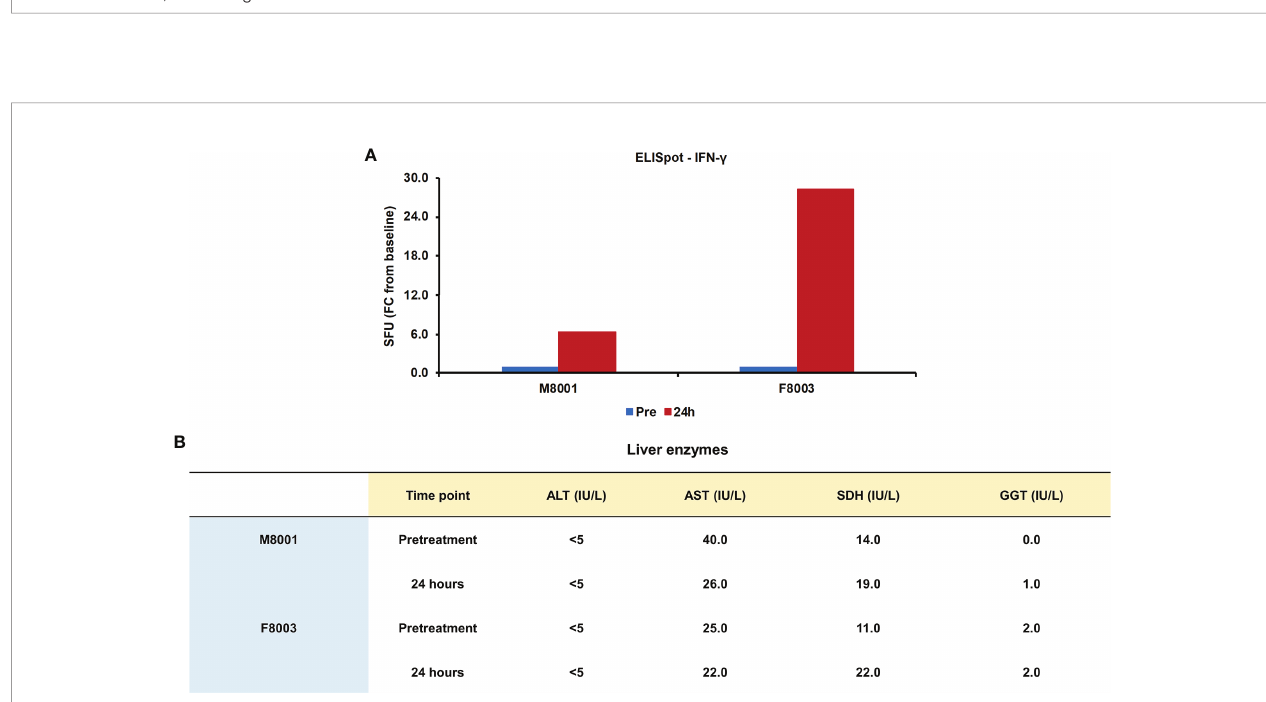
FIGURE 7 | Single dose administration of poly(dA:dT) to woodchucks results in agonistic activation of ZBP1/DAI and AIM2 receptor pathways in the liver and periphery. Liver biopsies and blood from animals M8001 and F8003 were collected 24 hours after intravenous injection of a single low (M8001) or high (F8003) dose of poly(dA:dT) in in vivo -jetPEI-Gal transfection reagent. The fold-changes in transcript level of receptors (ZBP1/DAI and AIM2) and effector cytokines (IFN- b , IL-18, and IL-1 b ) in (A) liver and (B) blood are shown, when compared to their transcript level at pre-treatment in liver biopsies and blood from the same animals, which was set at 1.0. FC, fold-change.